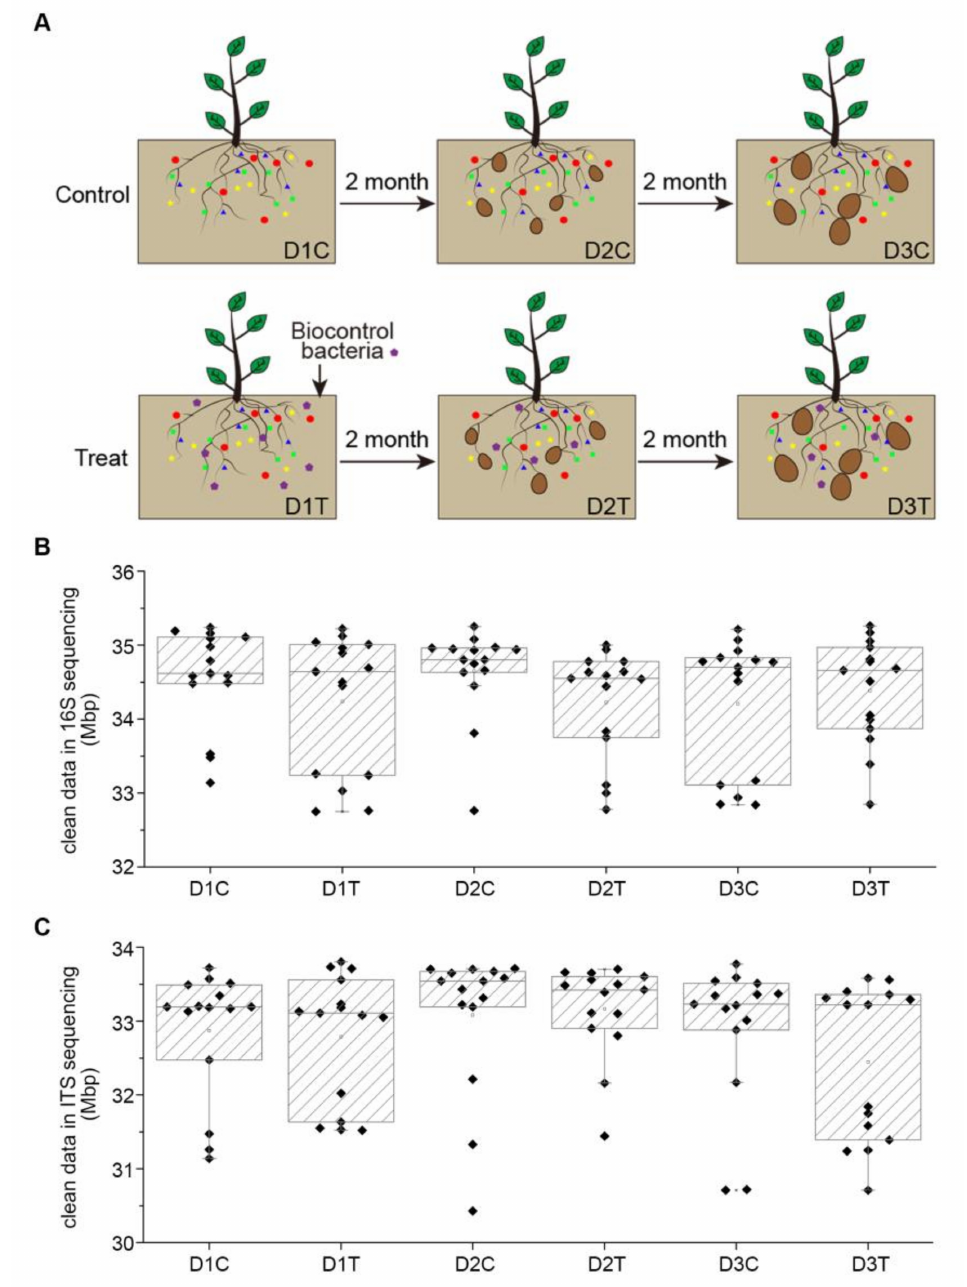
Figure 1. Characteristic of biocontrol treatment experiment and high-through sequencing. ( A ) Schematic diagram of experimental design. ( B ) The depth of 16S sequencing for each group of soil samples. ( C ) The depth of ITS sequencing for each group of soil